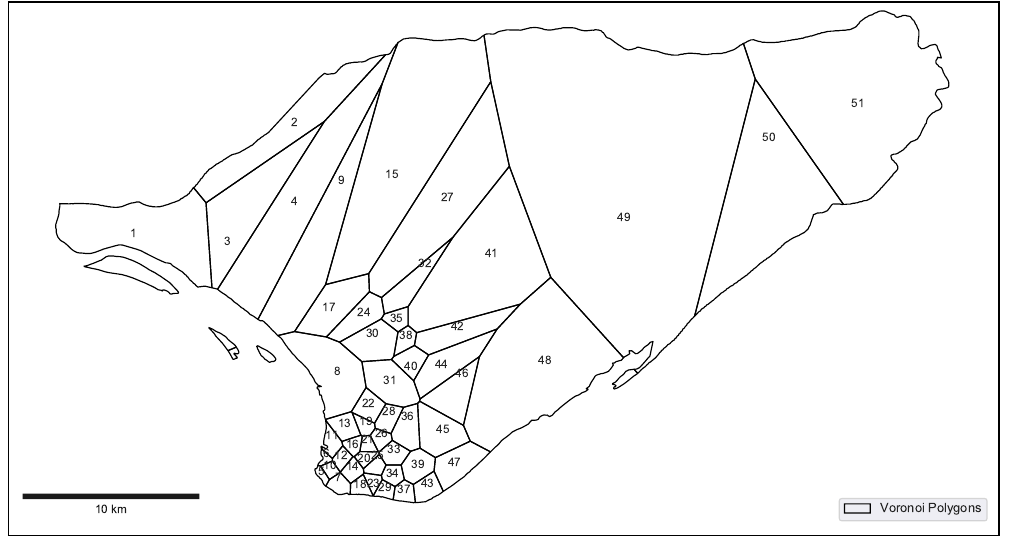
Figure 3. Voronoi polygons of the study